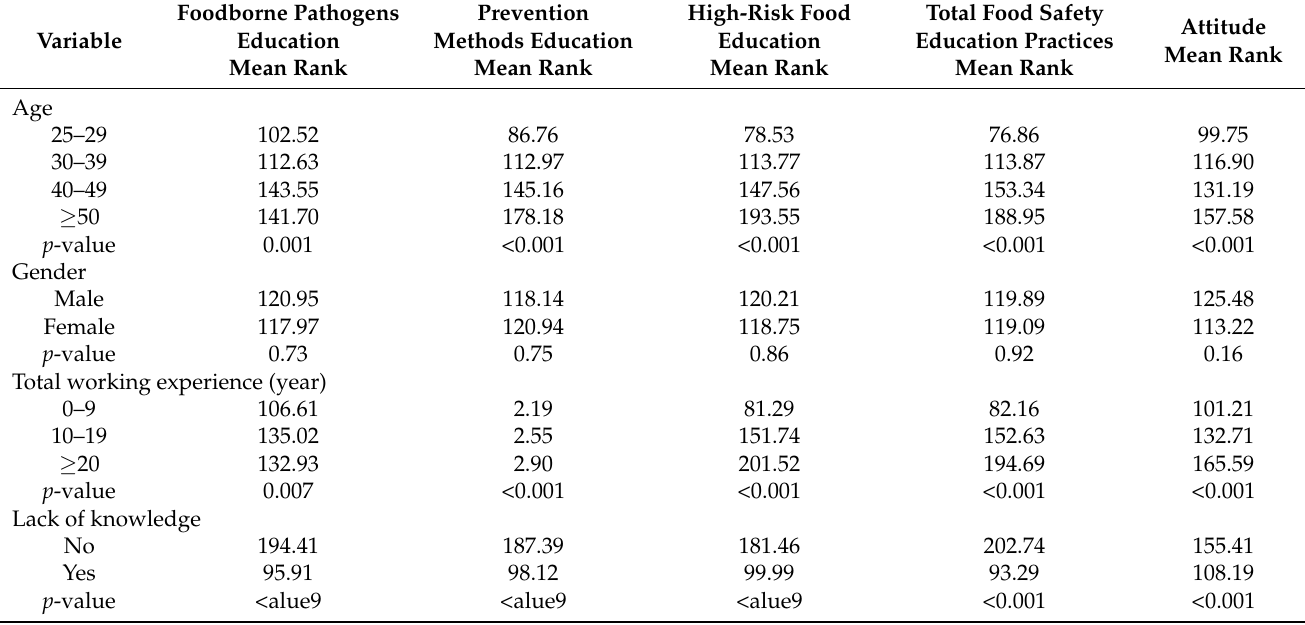
Table 3. Association between obstetrician’s attitudes, food safety education performance, and selected